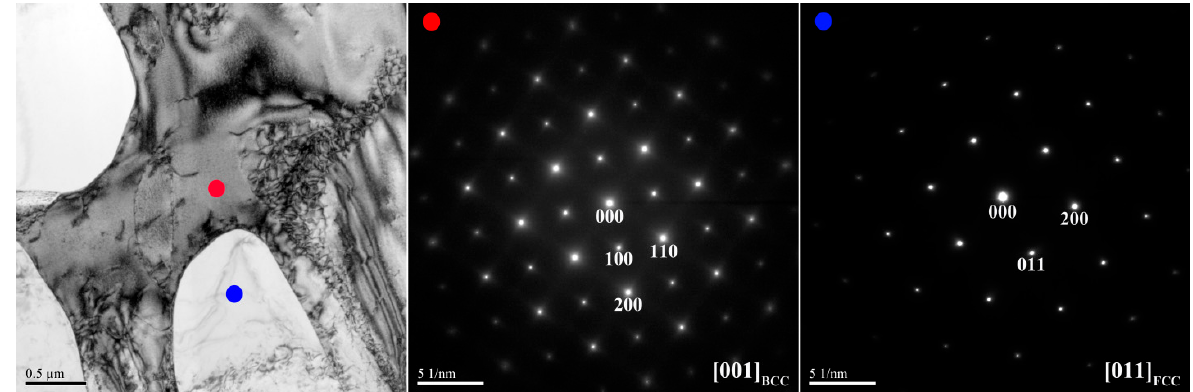
Figure 7. TEM bright-field image and SAED patterns of the interdendrite for the X 0.5 as-cast alloy (red dot: ordered BCC; blue dot: FCC). Table 5. Chemical composition (at.%) of the interior phases marked in Figures 6 and 7.